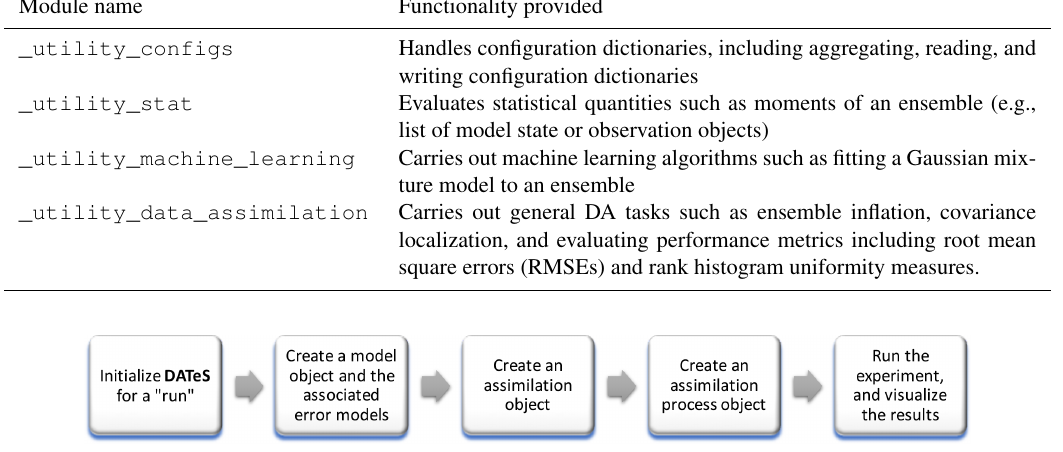
Figure 4. The sequence of essential steps required in order to run a DA experiment in DATeS.